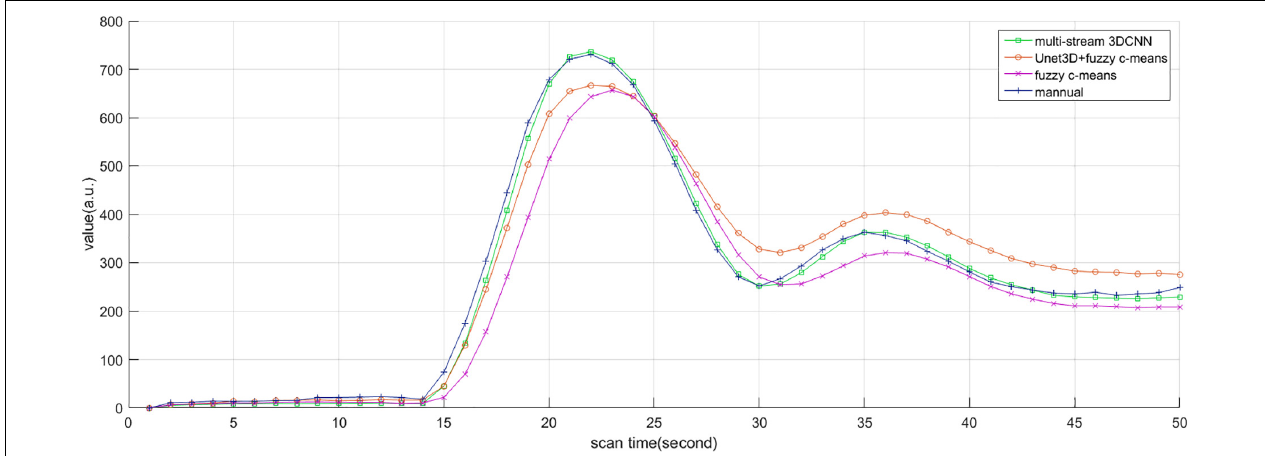
FIGURE 6 | AIF estimated by manual method, multi-stream 3DCNN, Unet3D + fuzzy c-means, and fuzzy c-means. AIF obtained by multi-stream 3D CNN is closest to the manual AIF.